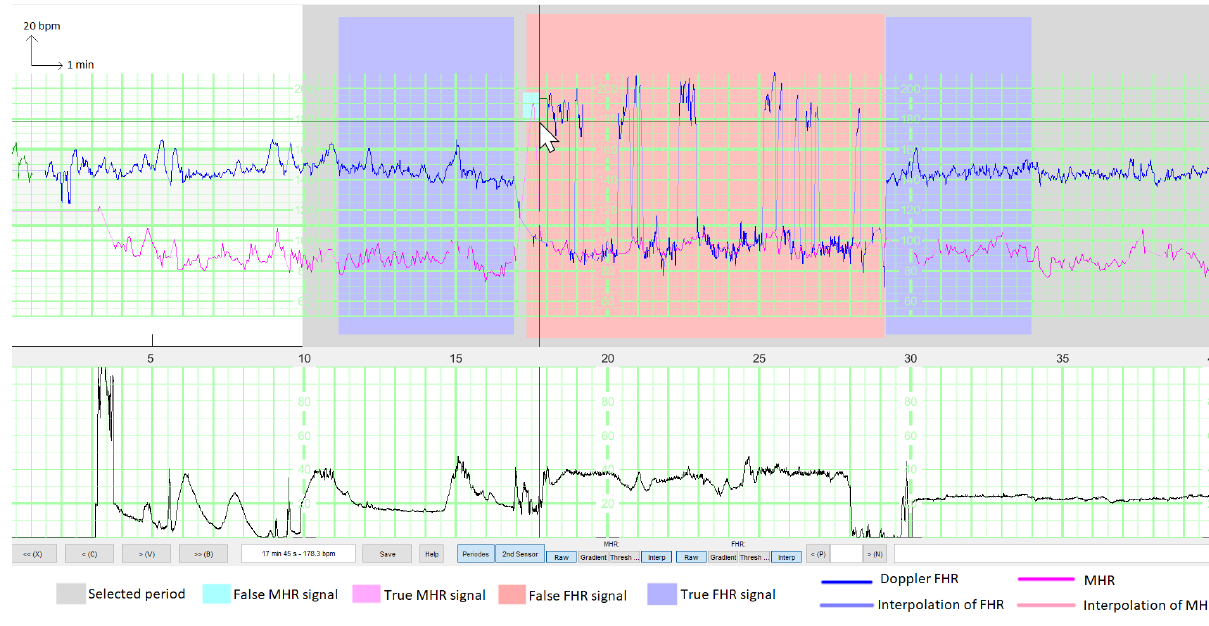
Figure 1. Illustration of the interface for annotating signals during a period with an epidural injection. Both the FHR (in blue) and the MHR (in purple) are shown, together with their interpolations (lighter colors) during MS periods (for better visualization of samples that are isolated from the rest of the signal). The user has selected a window for training the model (in grey) and has annotated two periods with a true FHR signal (in blue) and one period with a false FHR signal (in red). The false signals are either the MHR or the MHR × 2. Here, the user is selecting a few false MHR signals (in cyan) inside the rectangular